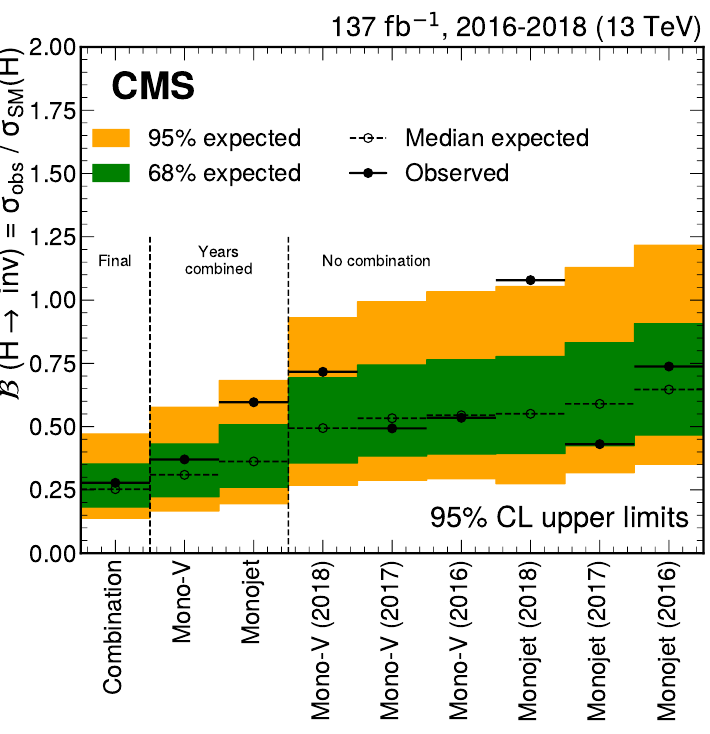
Figure 19 . Exclusion limits at 95% CL on the branching fraction of the Higgs boson to invisible particles. The result is shown separately for the monojet and mono-V categories in each data taking year, as well as their combination. The final combined limit is 27 . 8% ( 25 . 3%